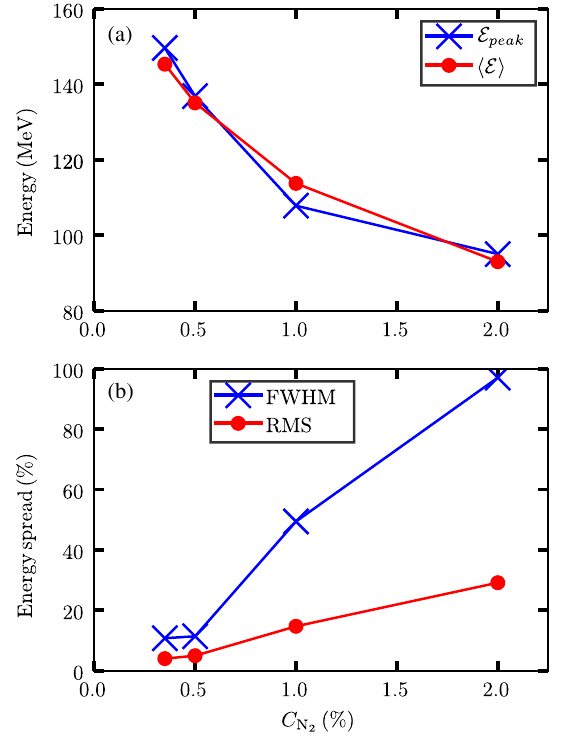
FIG. 7. Accelerated beam energy properties for each C (a) Peak energy E (blue crosses) and average energy h E i peak (red dots) with respect to C ; (b) Energy spread in full width at N 2 half maximum (FWHM), represented by blue crosses and root- mean-square (RMS), represented by red dots with respect to C